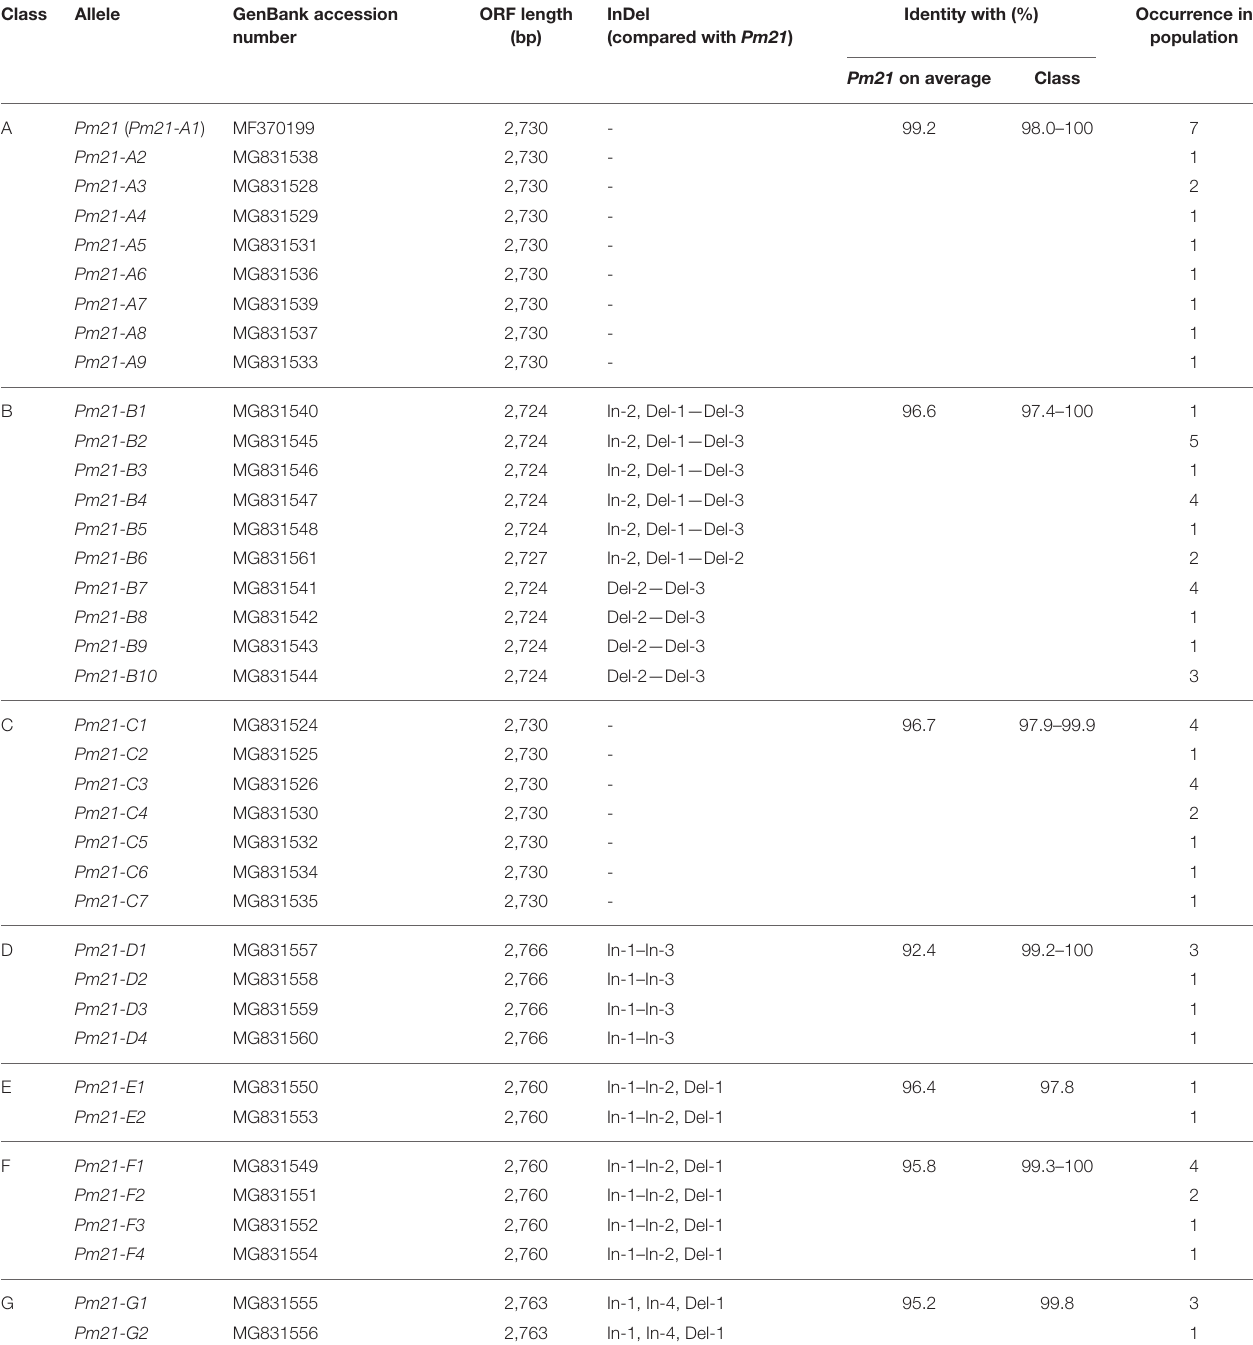
TABLE 3 | Classification of Pm21 alleles isolated from resistant individuals of D. villosum